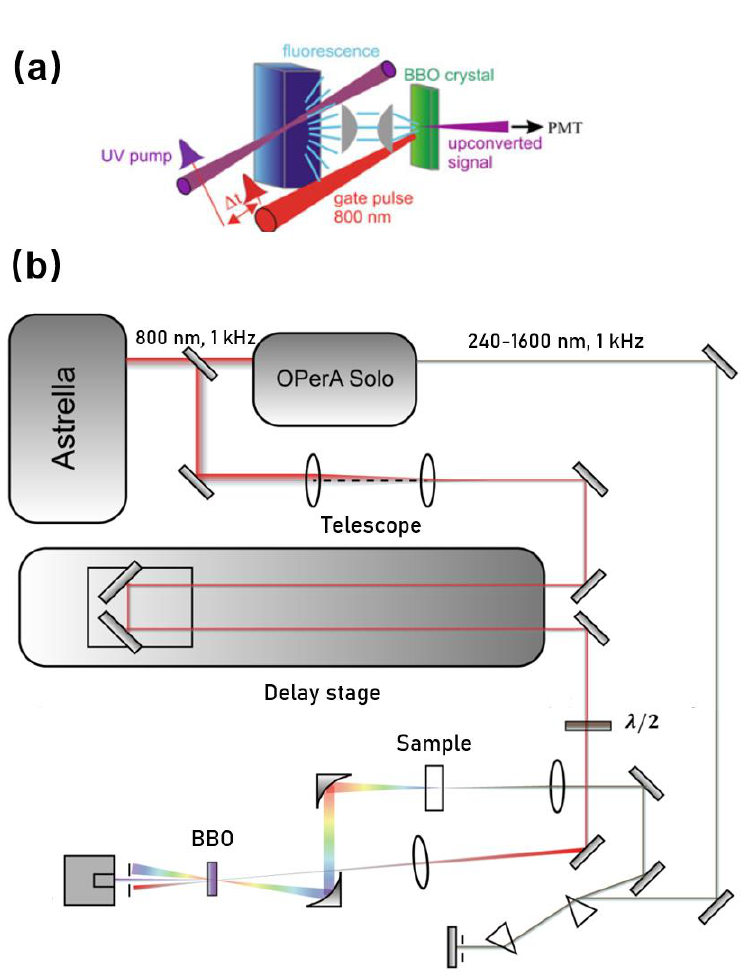
Figure 1. ( a ) Scheme of fs-resolved fluorescence upconversion and ( b ) the corresponding experimen- tal setup.